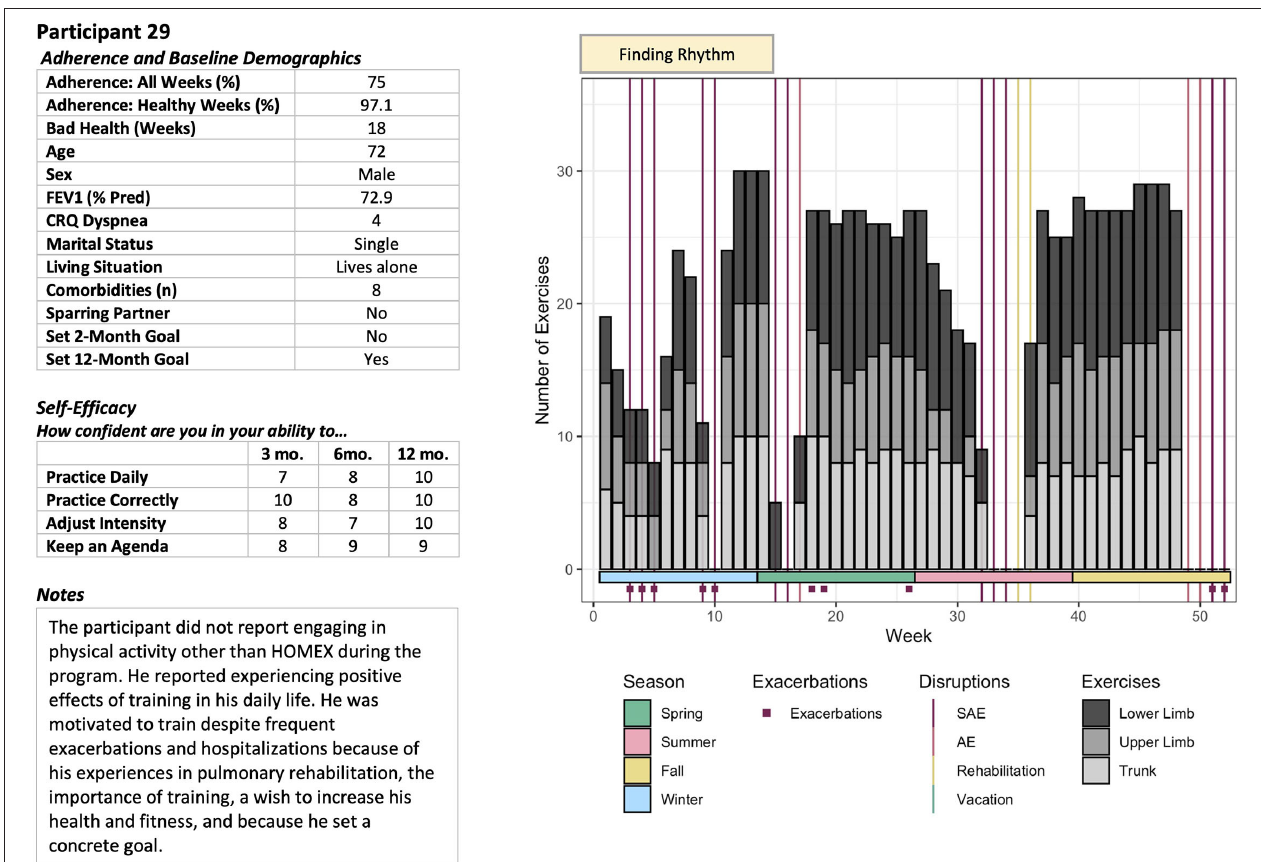
FIGURE 2 | Example of patient adherence visualization (participant